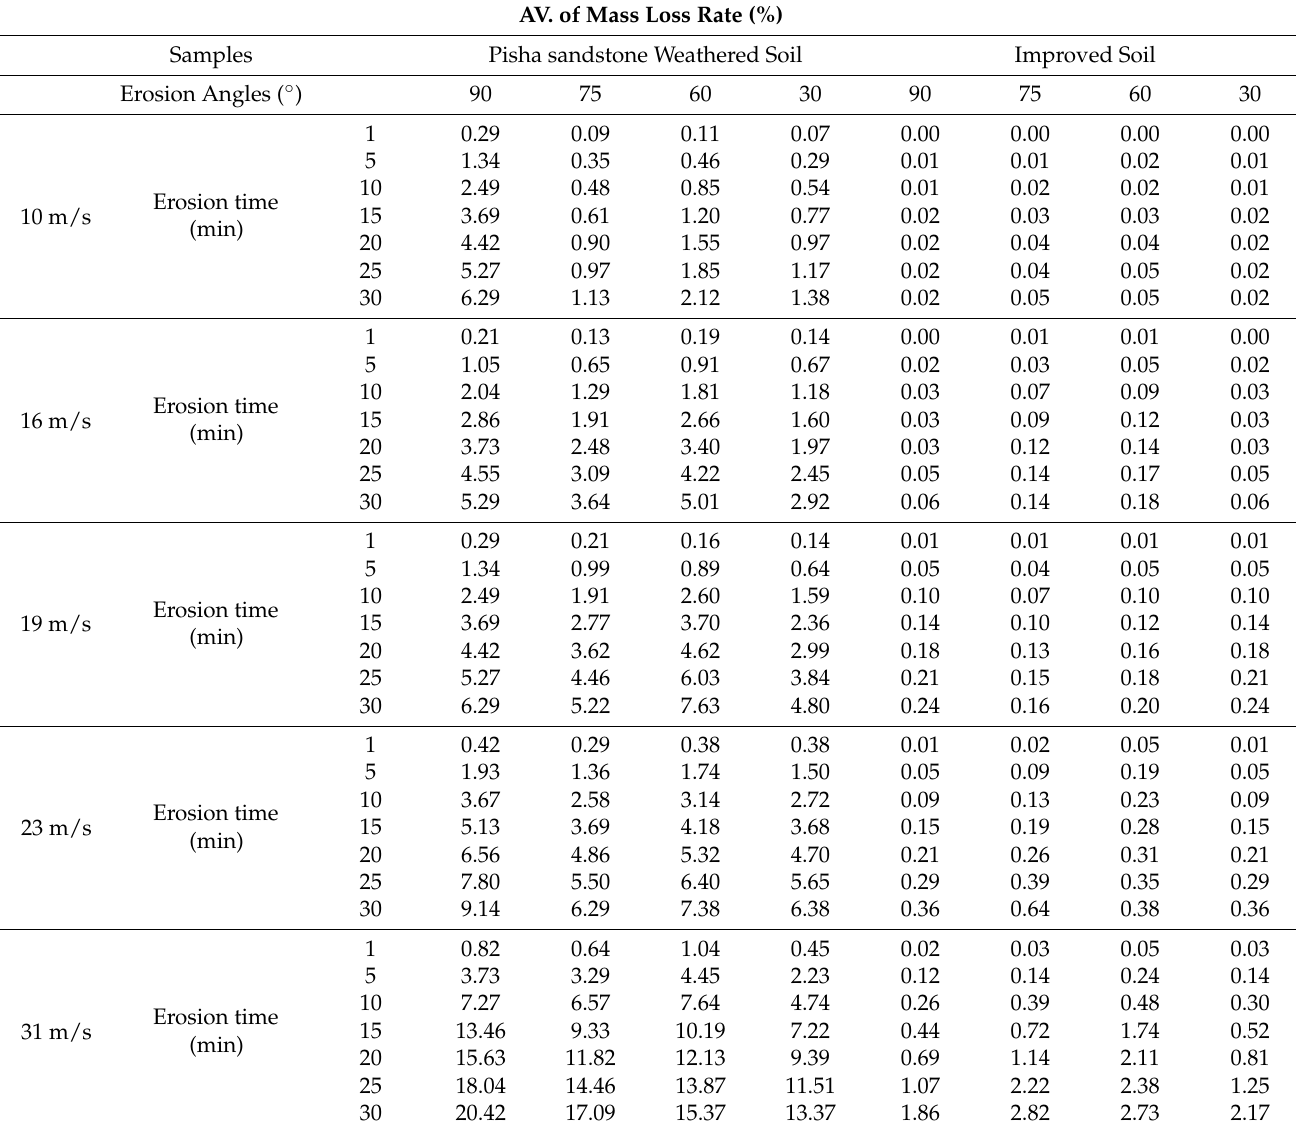
Table 8. Mass loss of samples after wind erosion